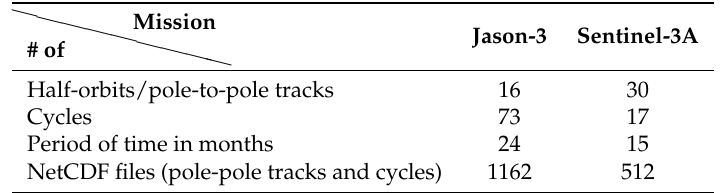
Table 1. Summary of J3 and S3A input L1 datasets to be